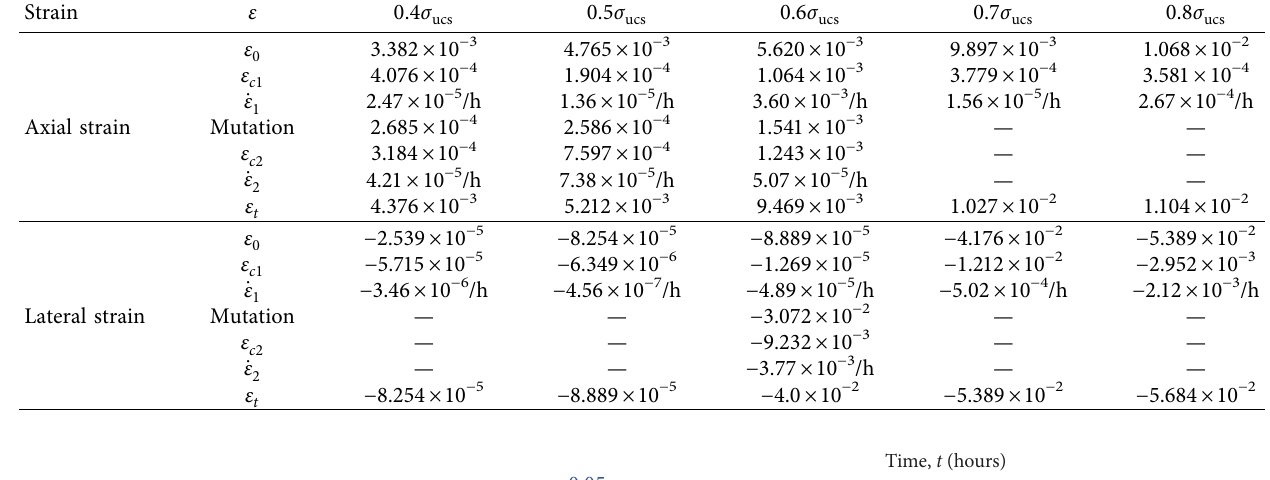
Table 3: Creep parameters of sample after oil erosion under diferent stress levels.